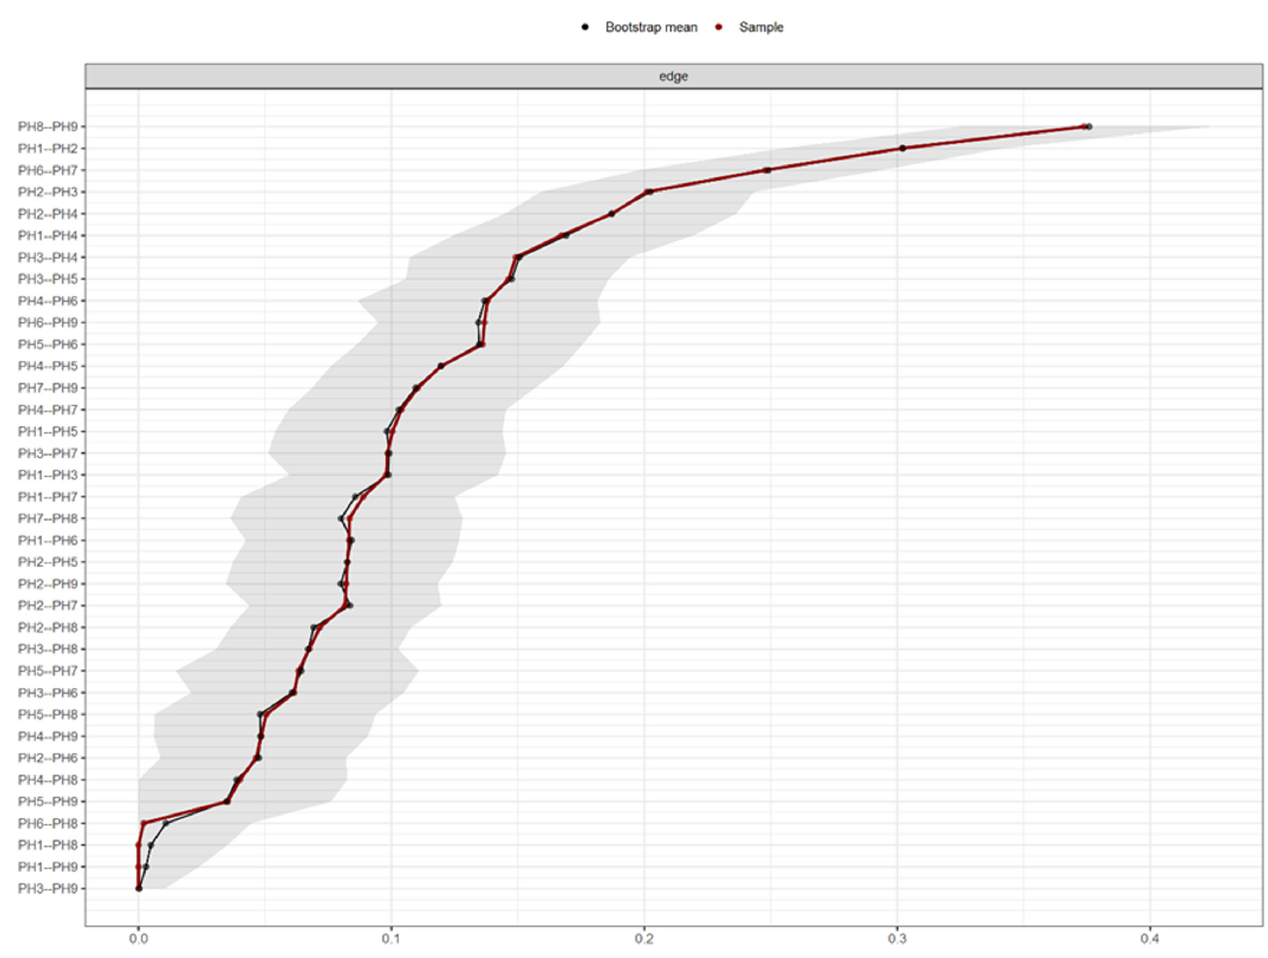
Figure 2. PHQ-9 network estimated border weight confidence intervals.